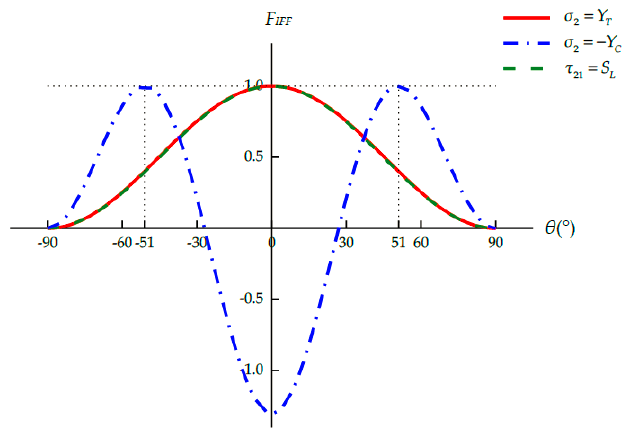
Figure 2. F IFF – θ relation under simple stress states for the ply in a unidirectional laminate.